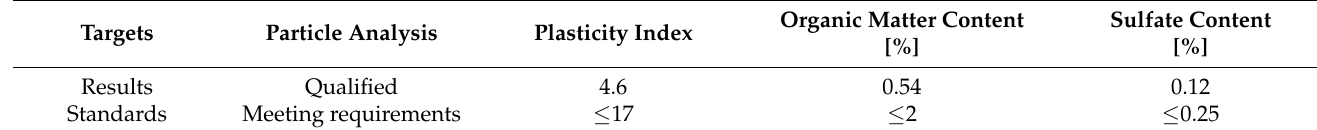
Table 4. Technical index test results for fine aggregates.